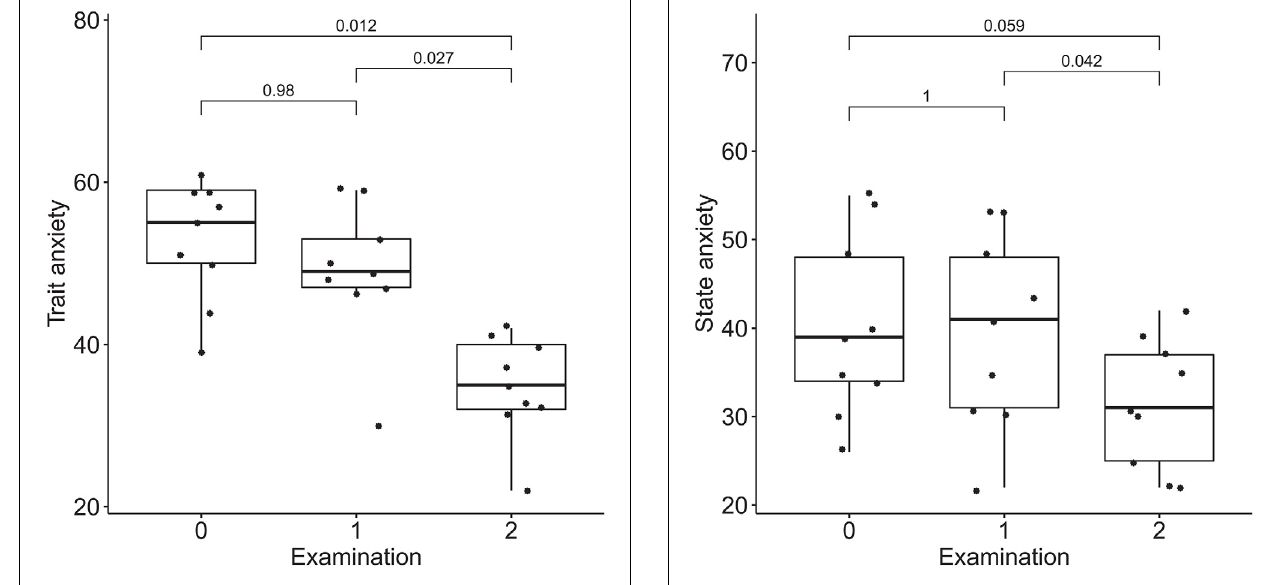
FIGURE 10 | Dynamics of state anxiety after the course of infra-low frequency neurofeedback. The examination was performed three times: (0) 2 to 4 months before enrollment, (1) at enrollment; and (2) after the neurofeedback course. Significance for the Wilcoxon pairwise comparisons is presented on the plot ( p -value, Bonferroni